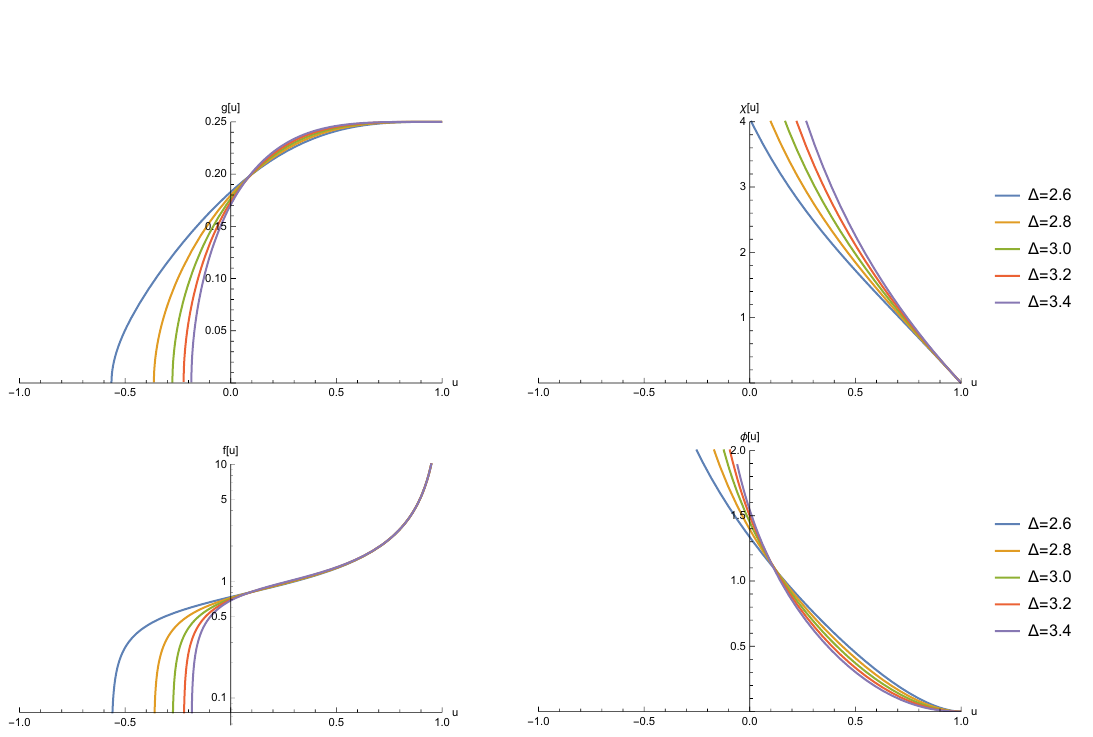
Figure 10 . Massive singular solutions for d = 4 with α = 7 . 0